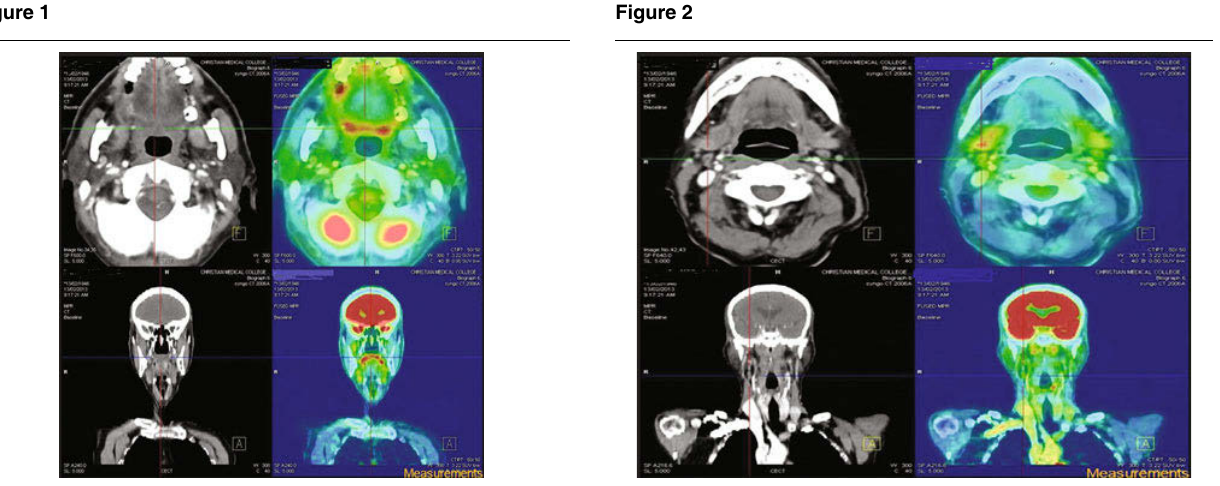
A focus of increased 18 FDG uptake [standardized uptake value (SUV) = 3.66] is noted in the left pyriform fossa. Corresponding computed tomographic (CT) images show mild mucosal thickening with partial obliteration of the left pyriform fossa.